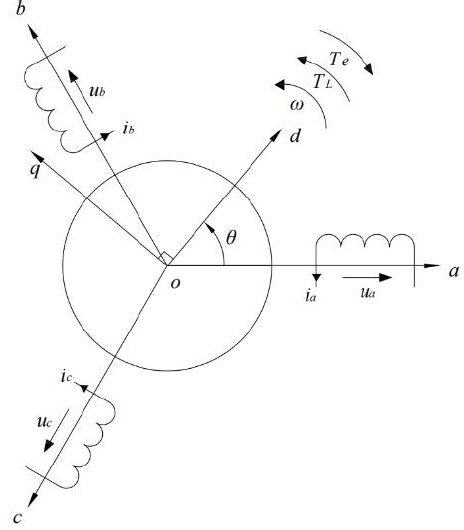
Figure 2. Conventional positive direction of permanent magnet generator.